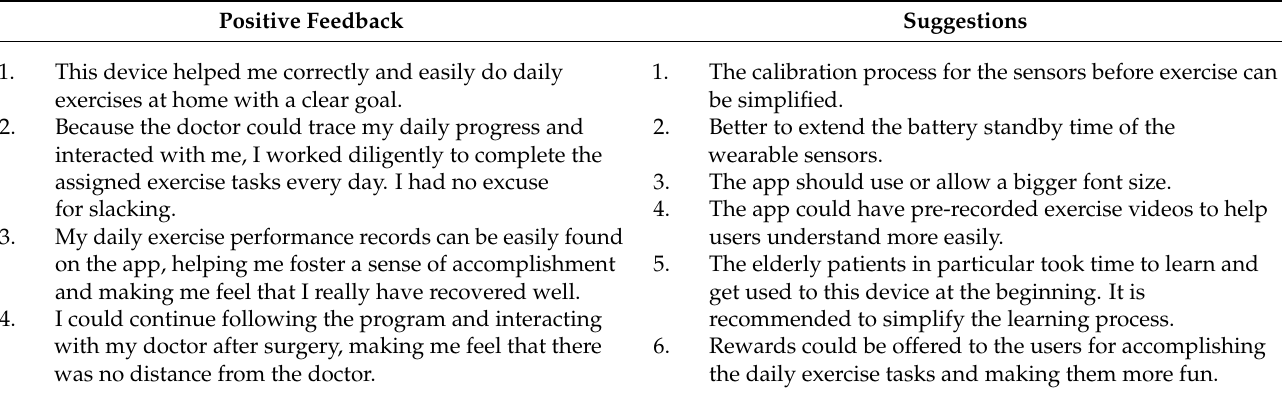
Table 6. Participant feedback for the overall MSD